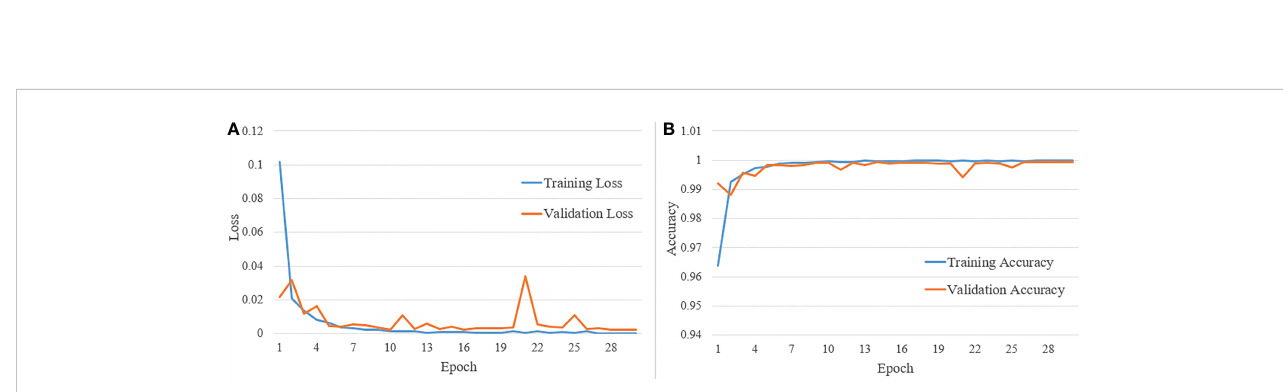
FIGURE 11 (A) Training and validation loss vs number of epochs; and (B) training and validation accuracy vs number of epochs.